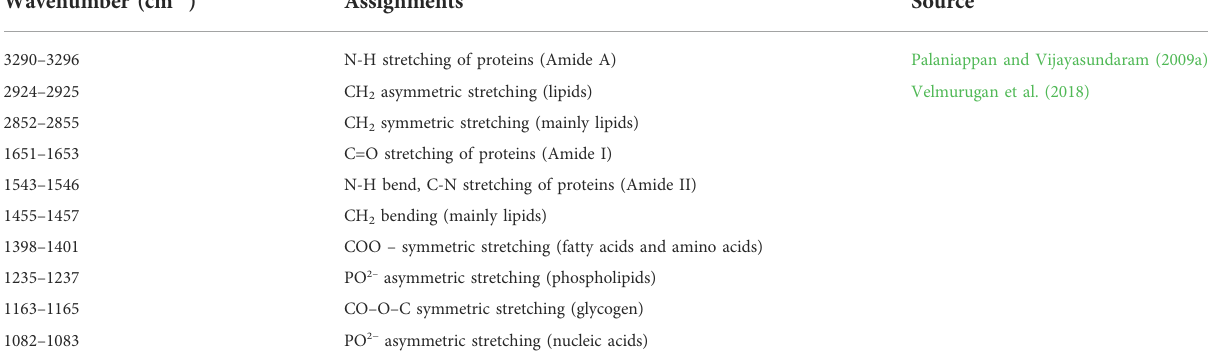
TABLE 3 Tentative Assignment of the observed